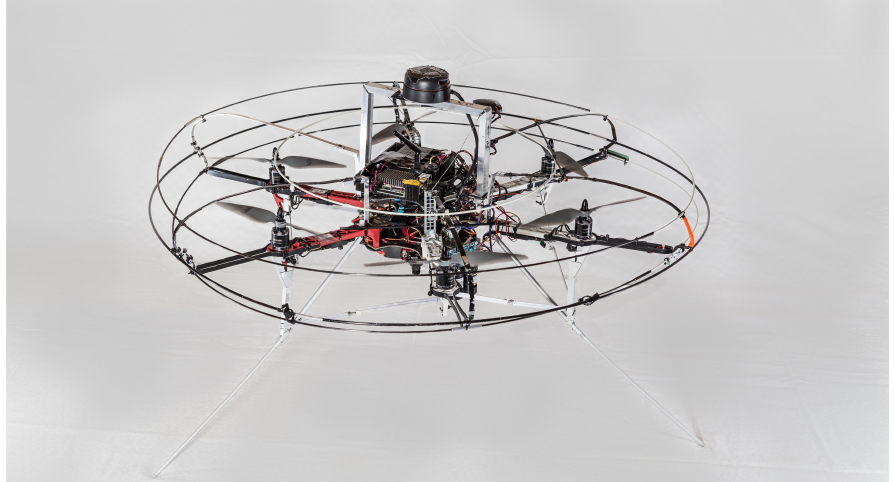
Figure 3. The hexacopter used for the real-life experiment is equipped with a RPLidar A2M4 laser scanner on top to sense its surroundings. There is a laser altimeter mounted at the bottom to sense the altitude of the UAV. The small Intel UPBoard and the Pixhawk autopilot are mounted below the laser scanner near the vehicle’s center of